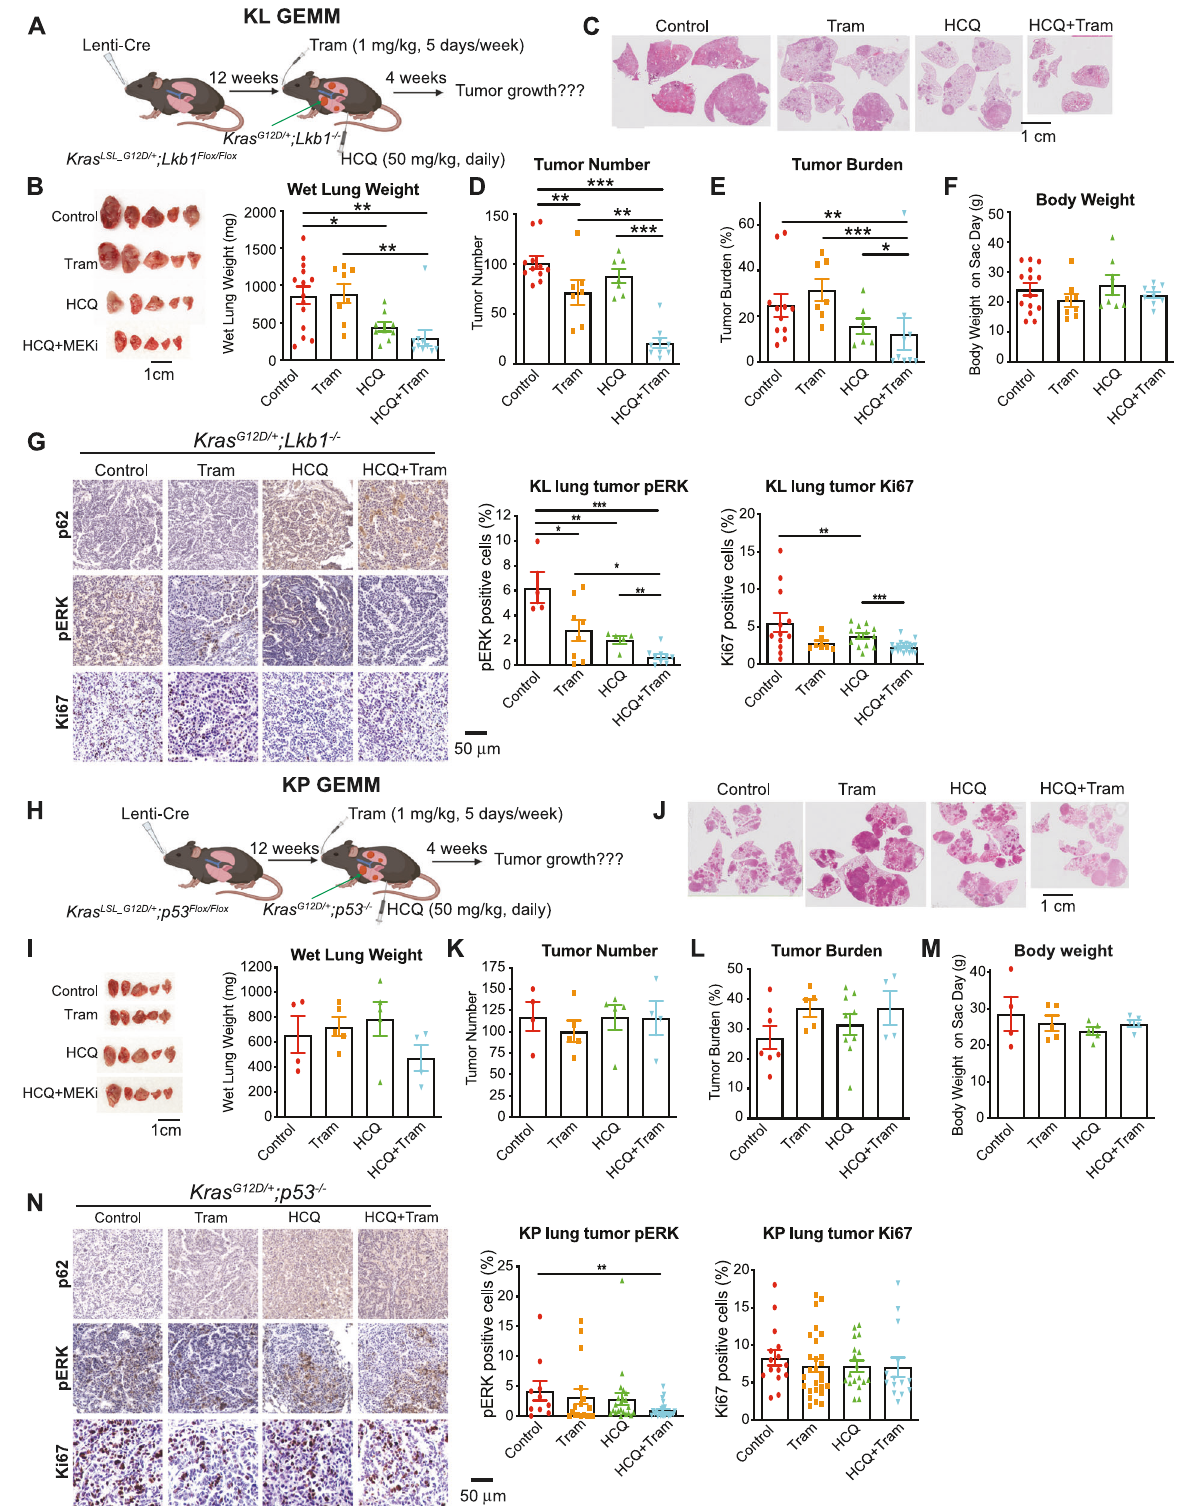
signi fi cantly reduced when combined with HCQ treatment (Fig. 5B). Compared with Trametinib alone, the combination of HCQ and Trametinib also resulted in a signi fi cant decrease in